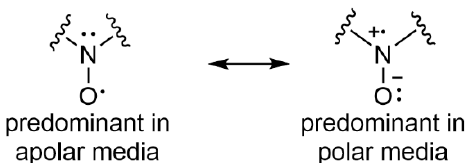
Figure 3. Equilibrium between limit mesomeric forms of a nitroxide.